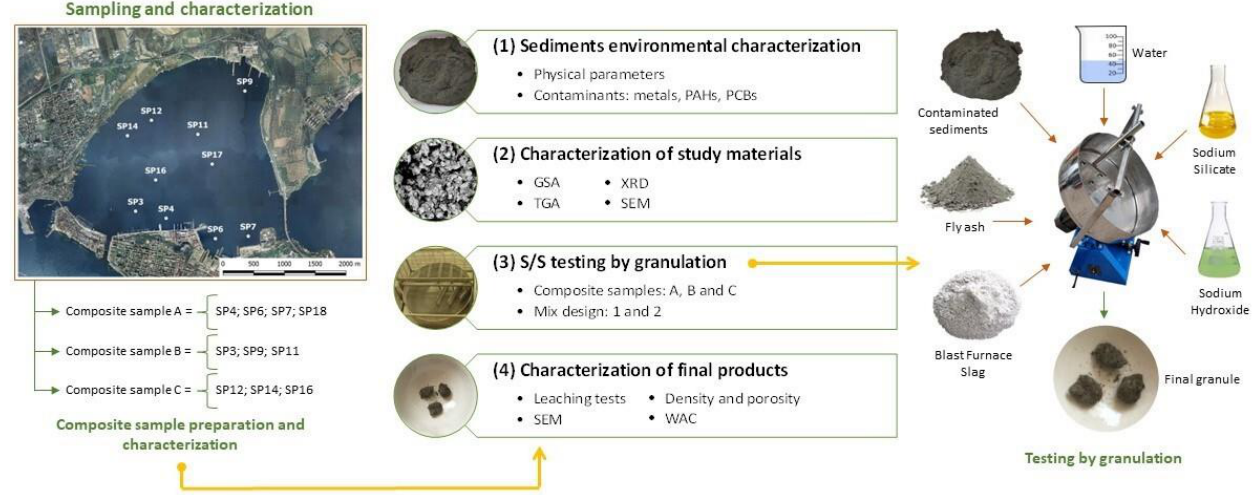
Figure 1. Overview of the experimental